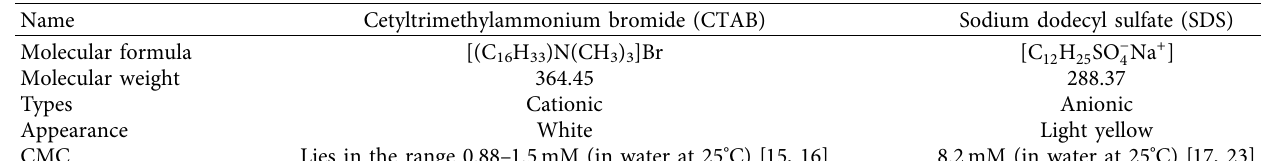
Figure 1: Schematic drawing using reverse micelles for solvent extraction [22]. Table 1: Physical properties of